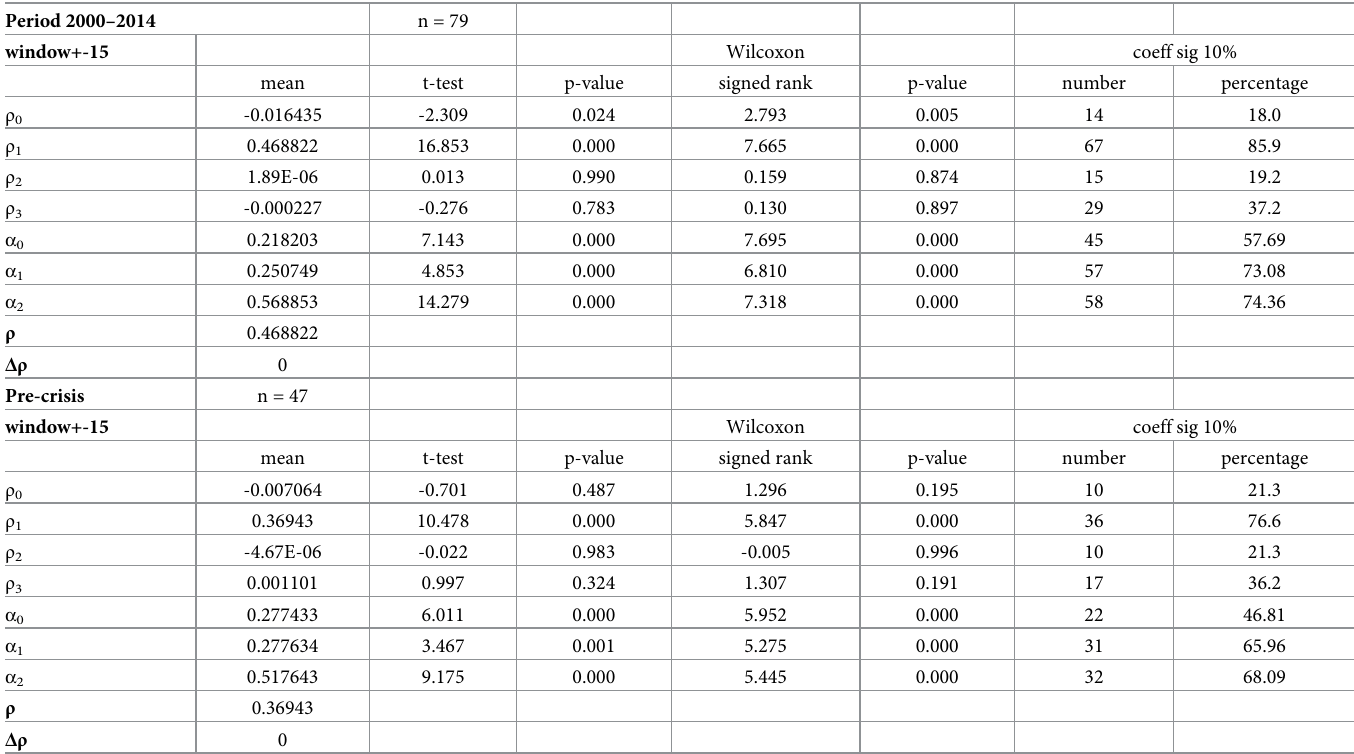
Table 14. Summary results–normalized: Italy. Period